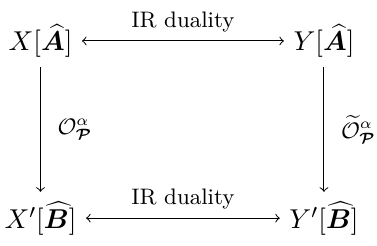
Figure 1 . Generating new dual pairs using an elementary S -type